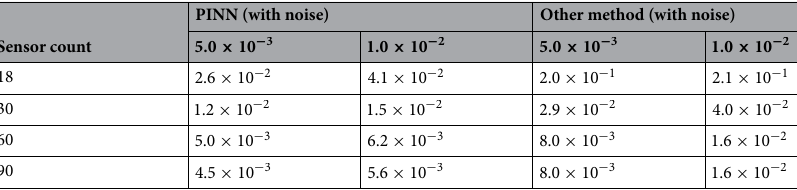
Table 4. Error measure in vector norm for the predicted and the other method for various sensor counts with Gaussian noise added to the sensor data with standard deviations σ = 5.0 × 10 −